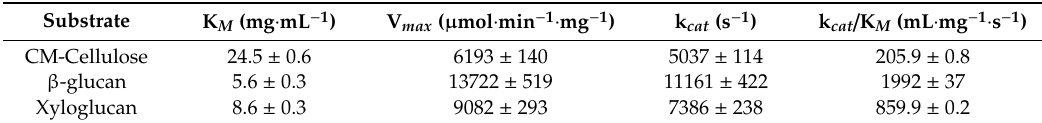
Table 1. Af-EGL7 kinetic parameters.